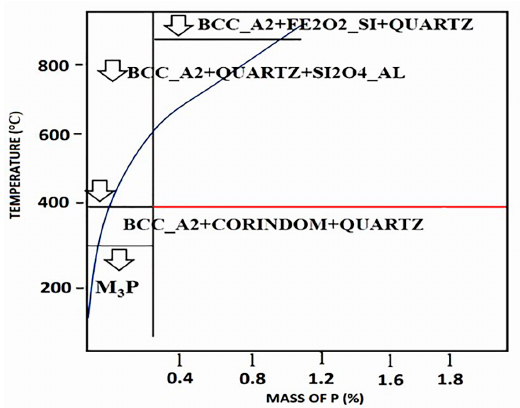
Figure 2. Phase diagram of iron ore with composition: Fe 60%, O 20%, Si 10%, Al 9.99%. Calculated using Thermocalc 